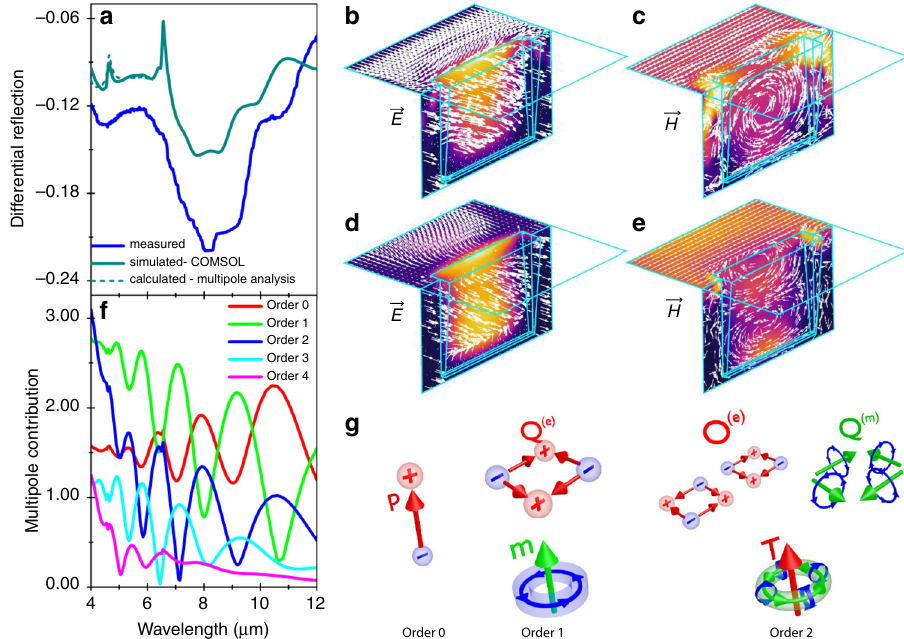
Fig. 4 Field maps and complex mode structure. a Experimental (solid blue), simulated (solid dark cyan) and calculated (dashed lines) differential re fl ection spectra of Bi 2 Te 3 metamaterial slit array of length 4.30 μ m. The fundamental and second-order resonances at 8.55 and 4.35 μ m, respectively, are evident in the plot. The sharp peaks in the simulated and calculated spectra around 4.60 and 6.50 μ m are due to diffraction effects. Maps of electric (E) and, magnetic (H) fi elds determined by FEM simulations showing the nature of the mode at the, b , c fundamental, and d , e second-order resonances. The maps have been calculated over one half of the slit, for simulation size purposes. The cyan outline overlaid on the color maps indicates the full slit and simulation region for clarity. f The contribution of various multipoles to the (displacement) current excitation induced in the metamaterial by the incident wave polarized perpendicular to the slits, including electric dipole (order 0), magnetic dipole (order 1), electric quadrupole (order 1), and toroidal dipole (order 2). g Schematic representation of the various modes in the metamaterial. See Supplementary Note 1 for further